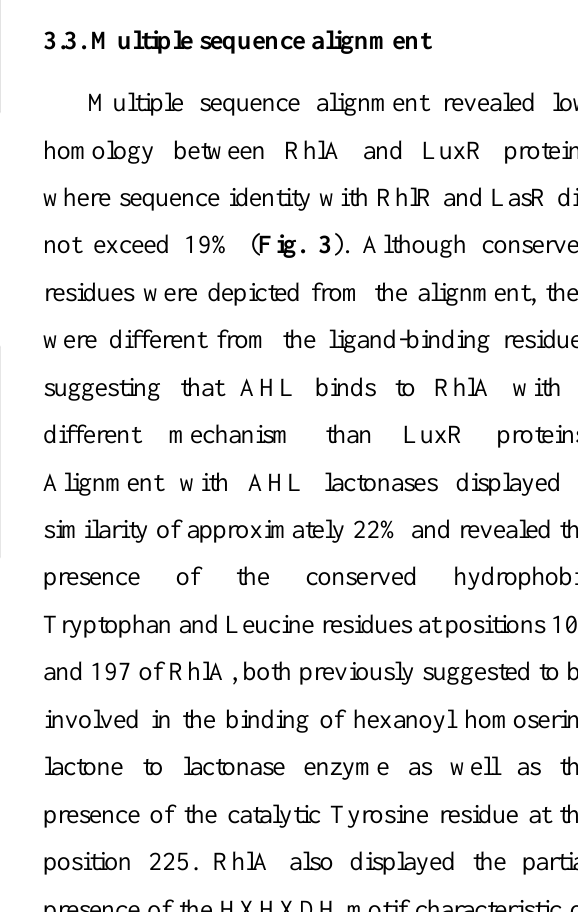
Fig. 2. (A ) Rhamnolipid synthase (RhlA) as depicted by I- Tasser. The protein chains are colored from blue at N- terminus to red at the C-terminus. ( B) The binding site for homoserine lactone in the RhlA enzyme is colored